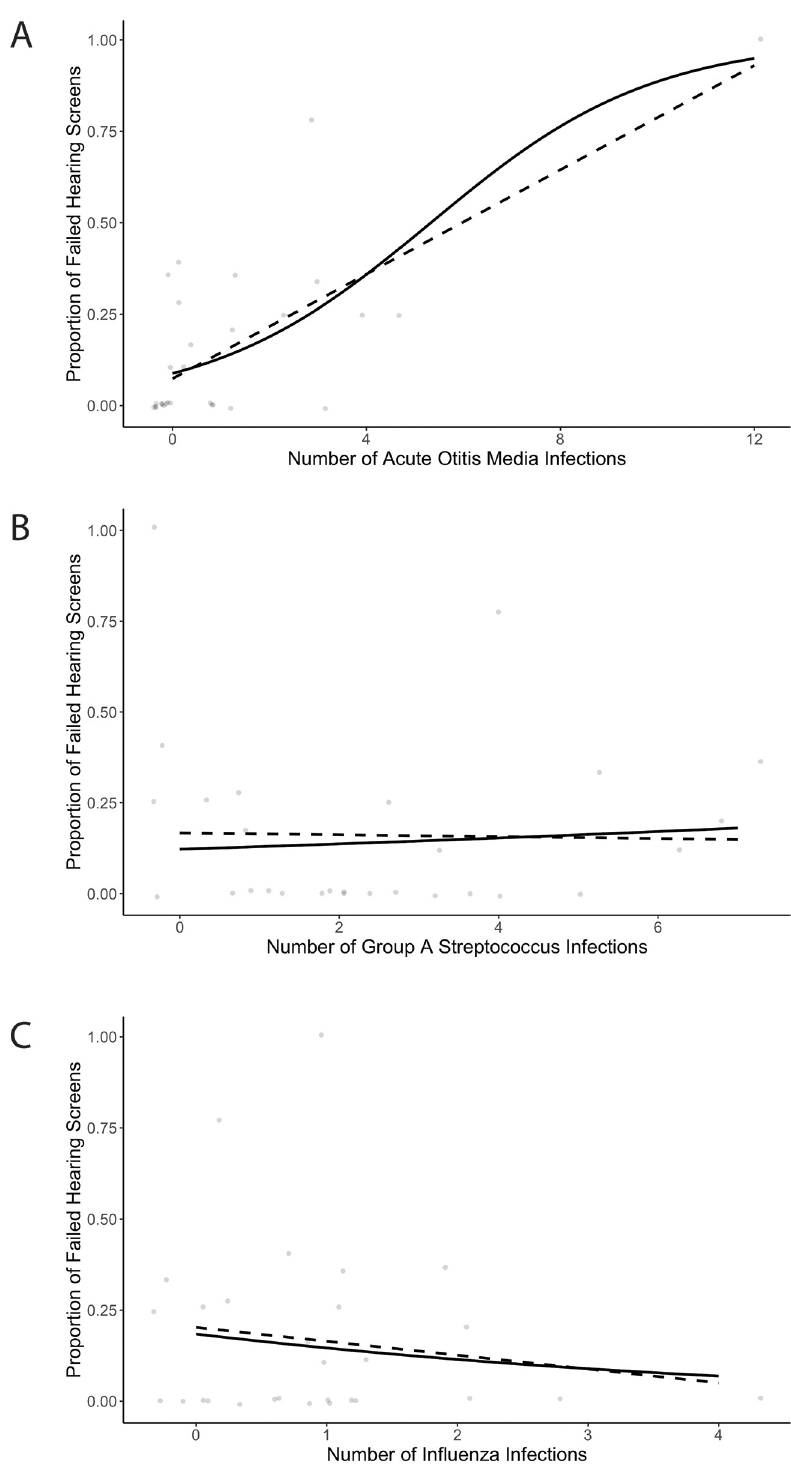
Fig 2. Association between URTI and number of failed hearing screenings in asthma. Number of AOM infections (Fig 1B), Number of GAS infections (Fig 2B), Number of Influenza infections in patients with asthma. Proportion of failed hearing screens was calculated as follows: number of failed hearing screens/total hearing screens. Solid line: binomial logistic regression. Dotted line: linear regression.